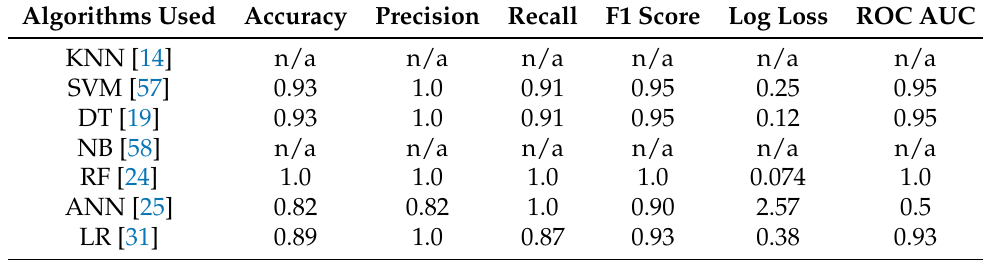
Table 11. Data exfiltration weighted classes results.